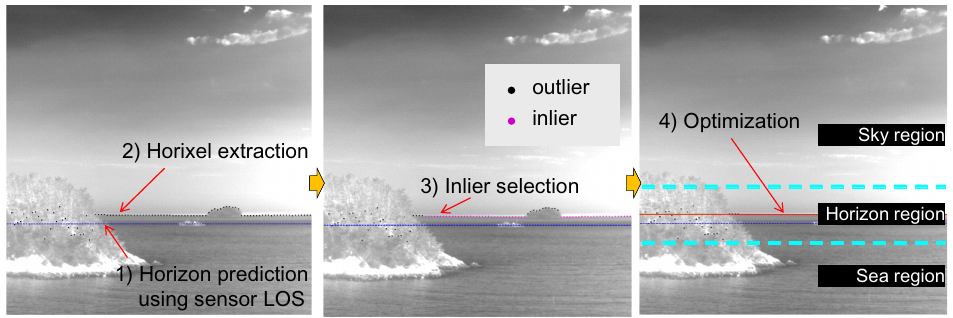
Figure 6. Region segmentation flow by horizontal line prediction and